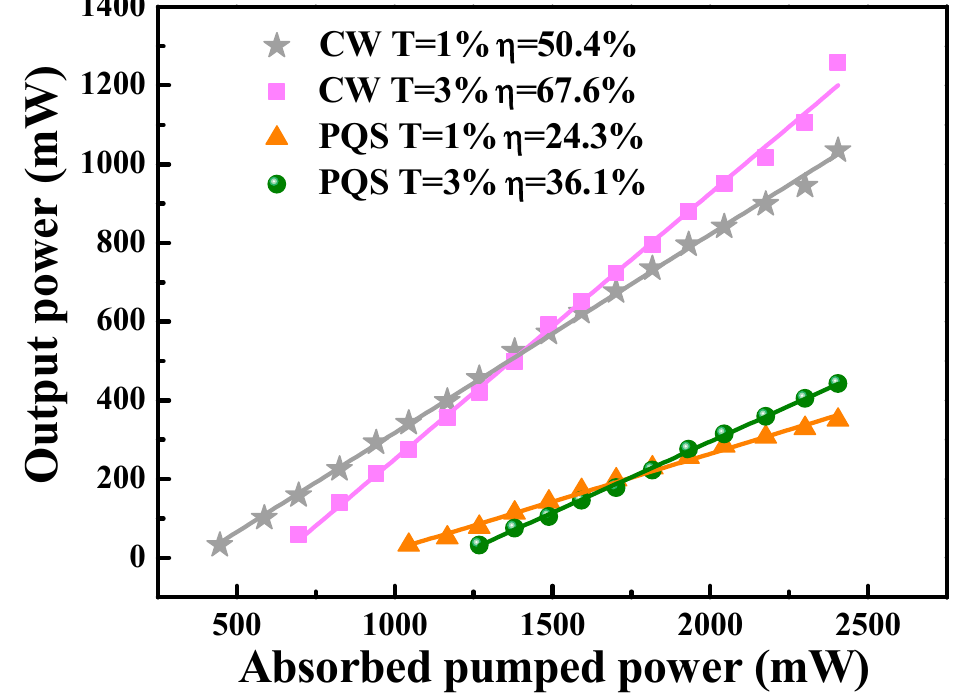
Figure 4. Output power versus the absorbed pump power for continuous-wave (CW) and